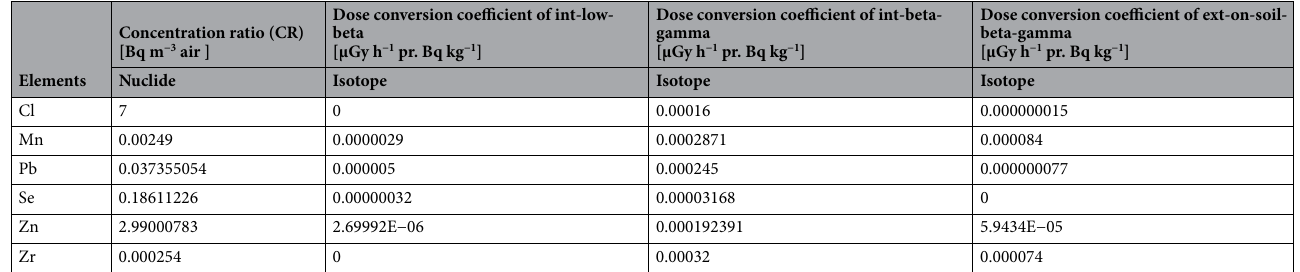
Table 8. Dose conversion coefficient of radionuclide in the human